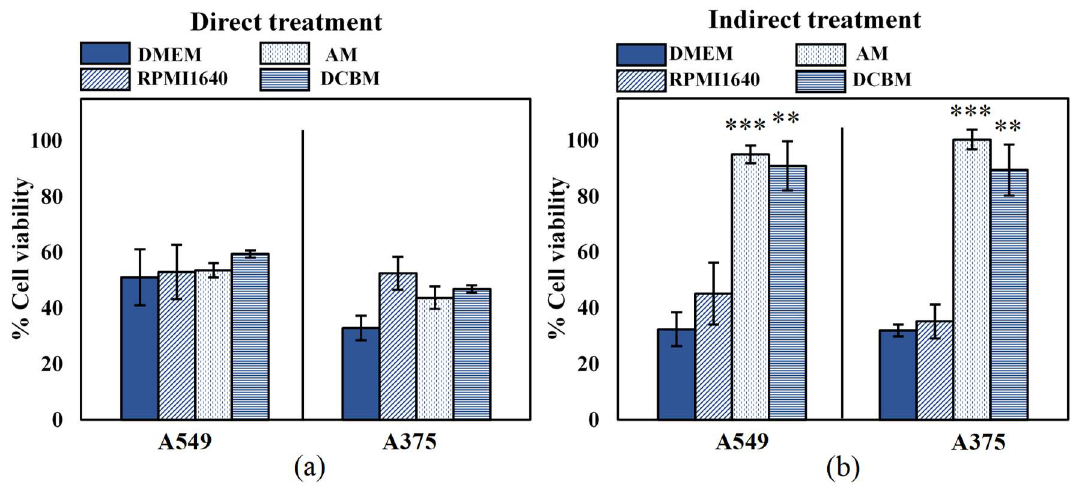
Figure 2. Influence of the cell culture medium on the direct and indirect plasma treatment of two cancer cell lines. ( a ) The direct plasma treatment was performed for 10 seconds, with a frequency of 500 Hz and a gap of 1 mm. ( b ) The indirect treatment was performed for 7 minutes treatment, with a gas flow rate of 3 slm and a gap of 10 mm. Data are represented as mean ± standard deviation (SD) of three independent experiments with at least two replicates. Statistical significance of all treatment conditions was compared to untreated. * p < 0.05, ** p < 0.01, and *** p < 0.005 (one-way ANOVA).